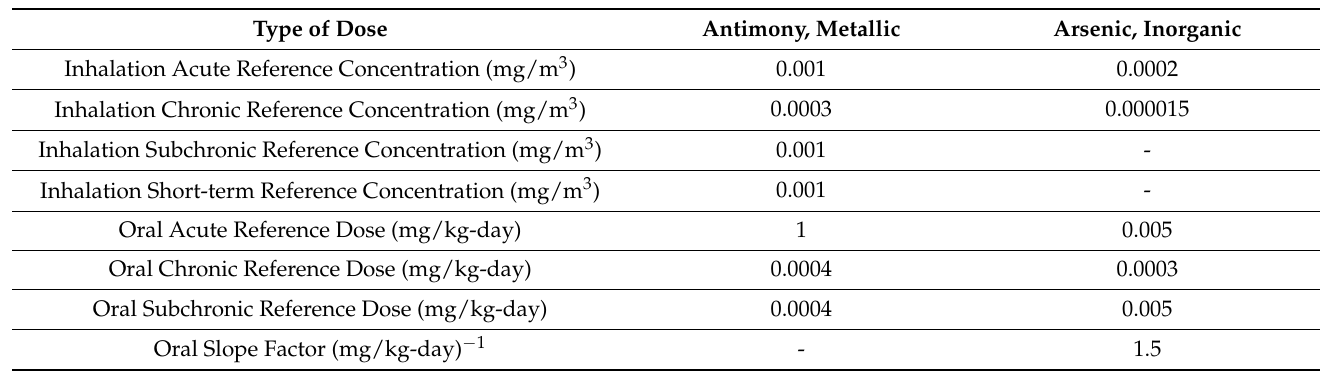
Table 3. Toxicological data for antimony and